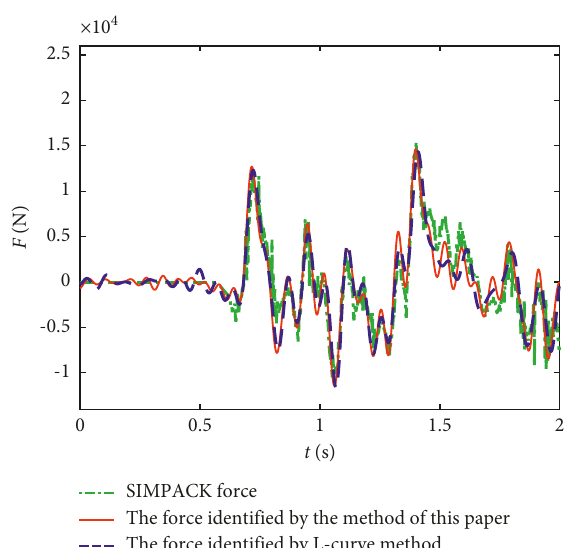
Figure 38: Load time-history diagram of the two methods for F